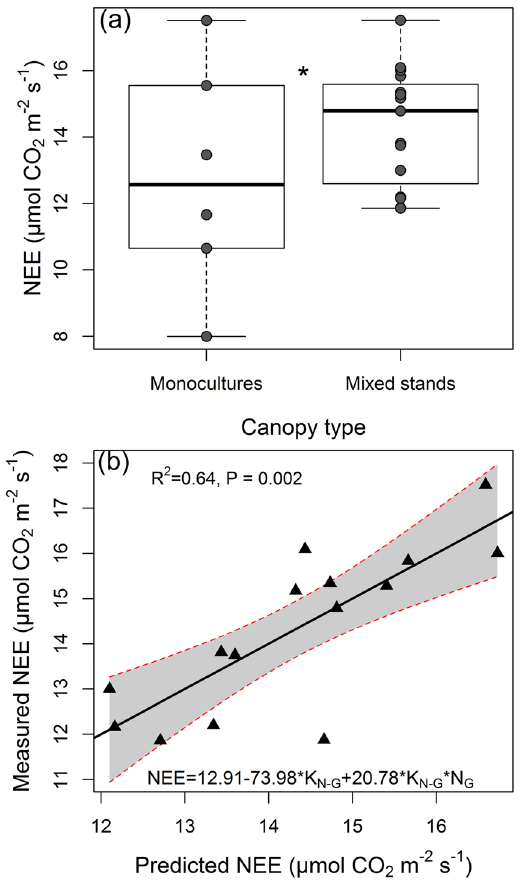
Figure 3. ( a ) Boxplots showing the median and variation in instantaneous CO 2 net ecosystem exchange (NEE) measured in monocultures and mixed stands. Multiple regression results from Table 3 show significantly different (P < 0.05, * ) regression coefficients for monospecific and mixed stands. ( b ) Relationship between predicted NEE values by the best model from Table 3 and measured NEE in mixed